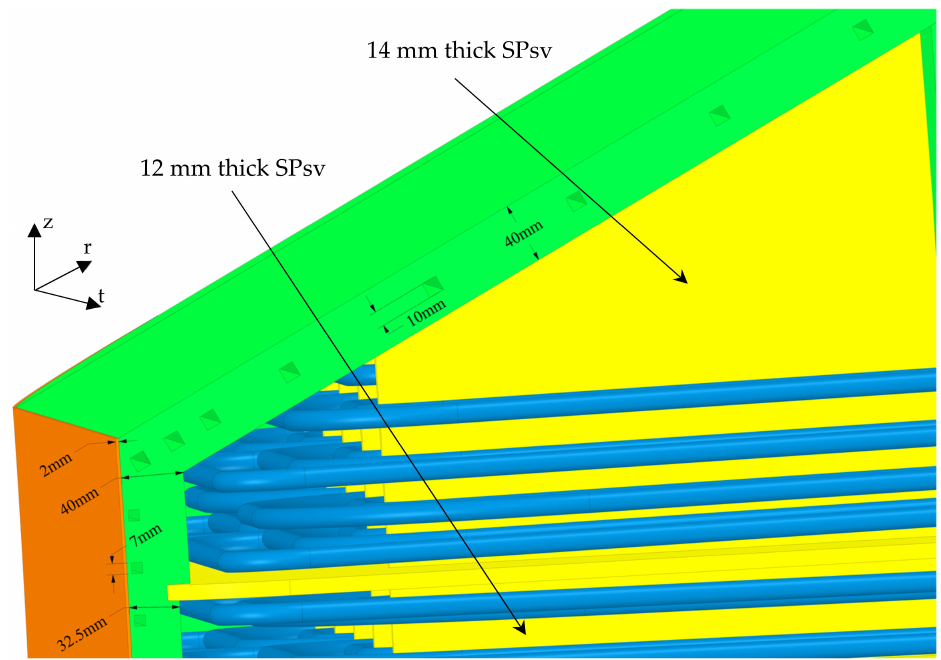
Figure 13. The “TC region-mod++” geometric